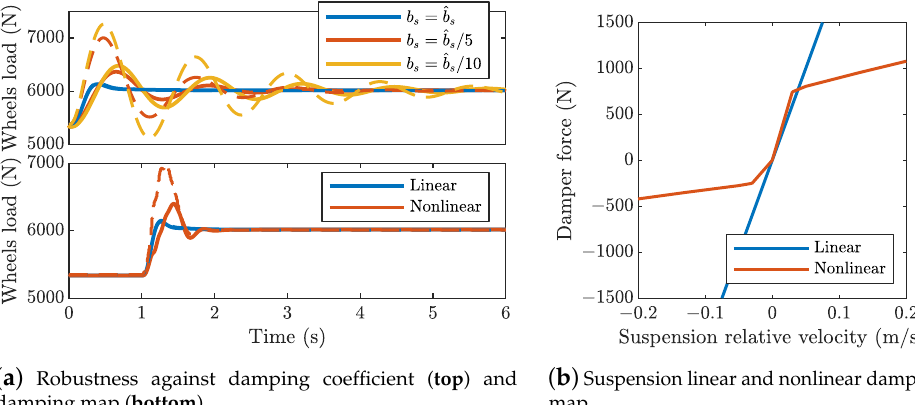
Figure 9. Robustness against uncertainties in the damping map during a braking maneuver. Solid lines show the ground-truth signals and dashed lines show the estimated ones.